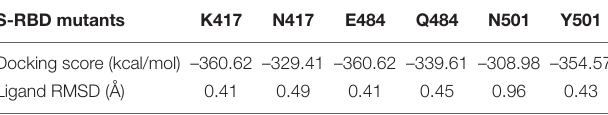
TABLE 2 | Docking scores for the S-RBD and hACE2